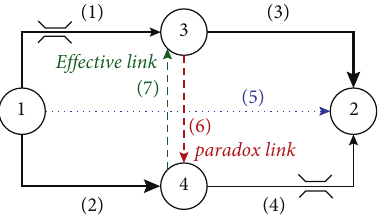
Figure 4: The Braess network for network capacity